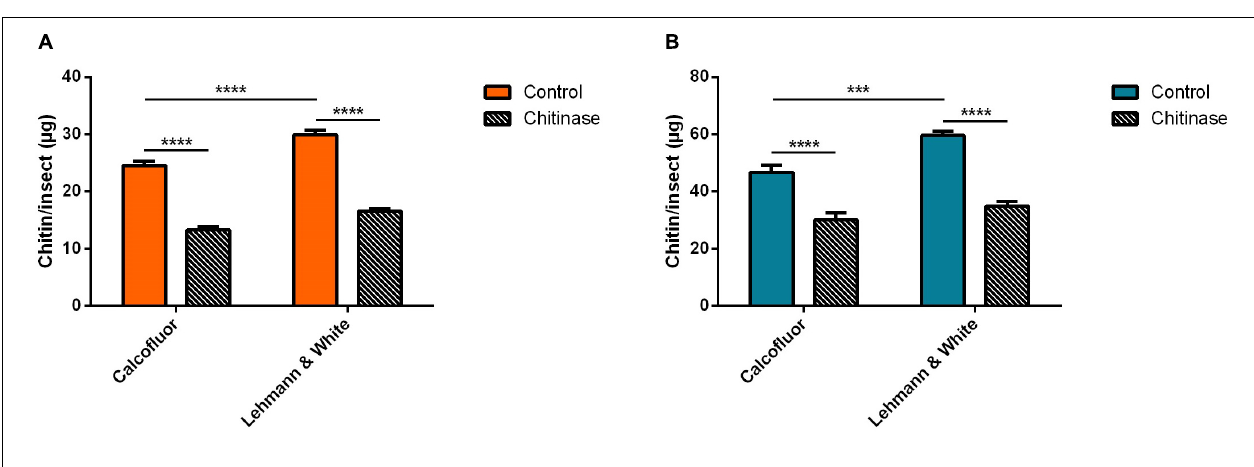
FIGURE 4 | Chitin content assessment in adult Aedes aegypti pooled in groups of 20 in 200 µ L distilled water, before and after treatment with 1 mg/mL chitinase from Streptomyces griseus . We also compare measurement methods by Lehmann and White (1975) and the calcofluor fluorescent brightener. (A) Male A. aegypti . (B) Female A. aegypti . Bars are means of 30 biological replicates with the standard error of the mean (SEM). Asterisks denote statistically significant differences, *** p ≤ 0.001, and **** p ≤